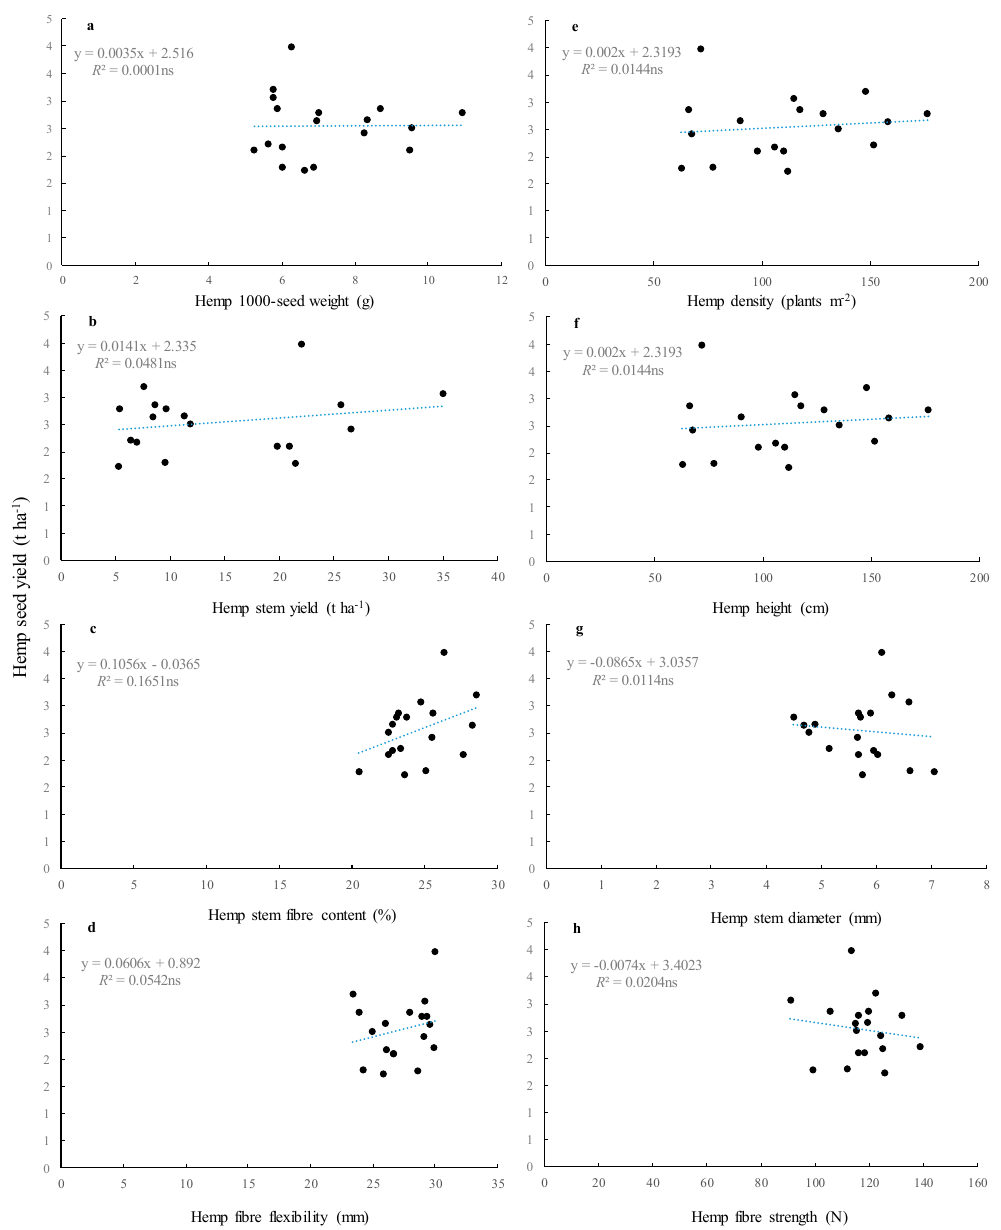
Figure 7. Correlations (linear regressions) between hemp seed yield and ( a ) 1000-seed weight, ( b ) stem yield, ( c ) stem fibre content, ( d ) fibre flexibility, ( e ) plant density, ( f ) height, ( g ) stem diameter and ( h ) fibre strength of six hemp varieties. ns = no significance